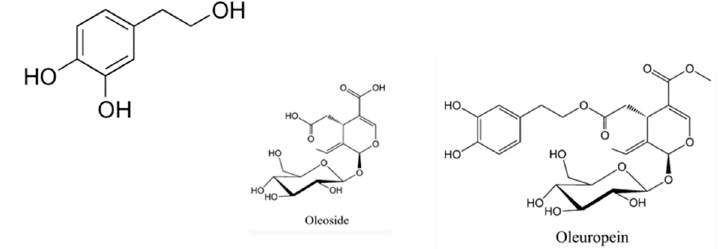
Figure 1. Chemical structure of hydroxytyrosol and derivatives.